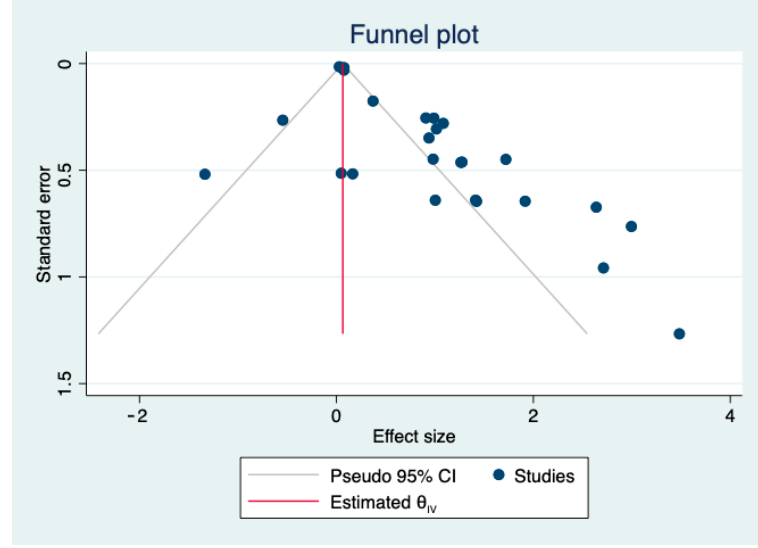
Figure 5. Funnel plot of the selected studies assessing publication